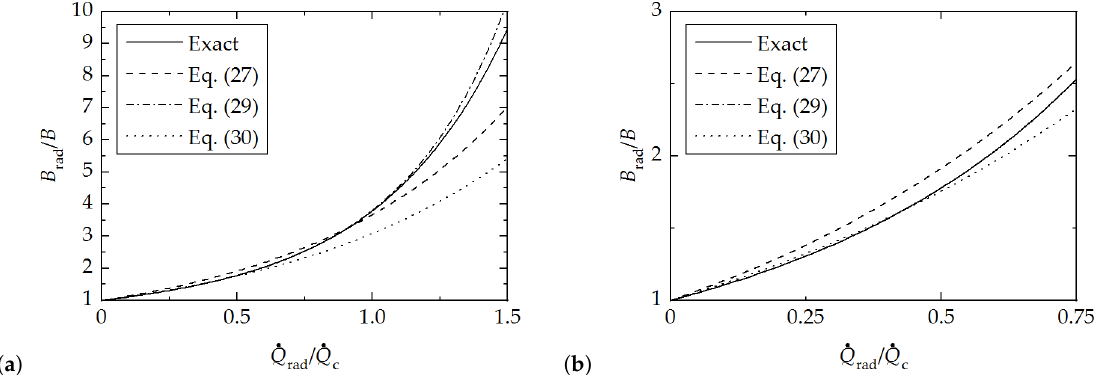
Figure 3. Comparison of different expressions for the radiation correction shown ( a ) over a wide range of heat flux ratios, and ( b ) over a more practical